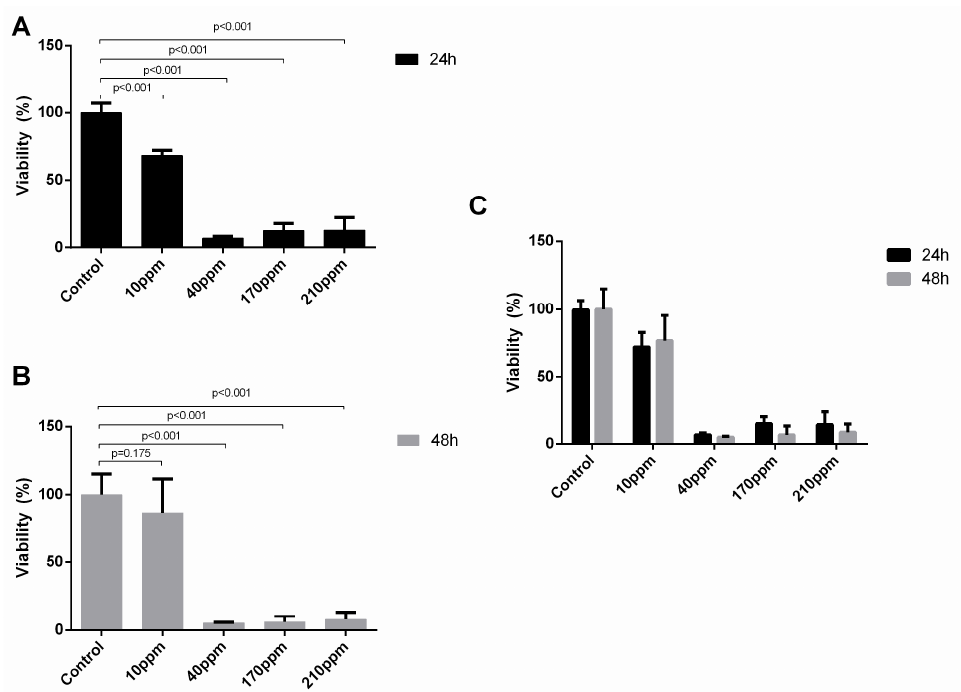
Figure 6. Evaluation of cell viability, by WST-1 assay, upon LNCaP cells treatment with AgNPs at concentrations of 10–210 ppm for 24 h ( A ) and 48 h ( B ) and the comparison between their effect at the two time points ( C ). Results are expressed as percentage of control (untreated cells), as mean ± SEM.